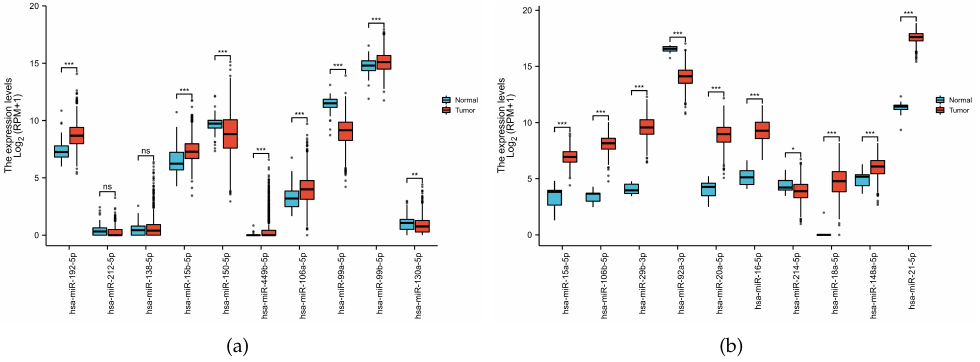
Figure 6. The result of the miRNA differential expression. ( a ) miRNAs ranked 1–10 for breast cancer. ( b ) miRNAs ranked 1–10 for colon